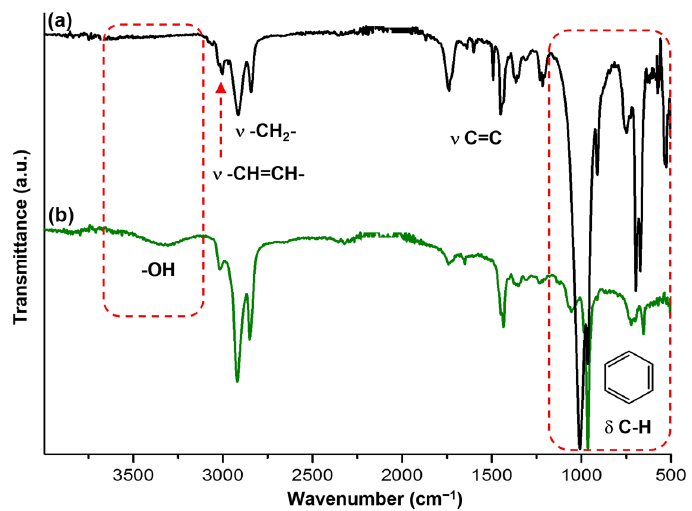
Figure 1. FT-IR spectra of ( a ) SBS and ( b ) biobased HTPB synthesized via metathesis degradation from SBS using 10-undecen-1-ol as CTA.